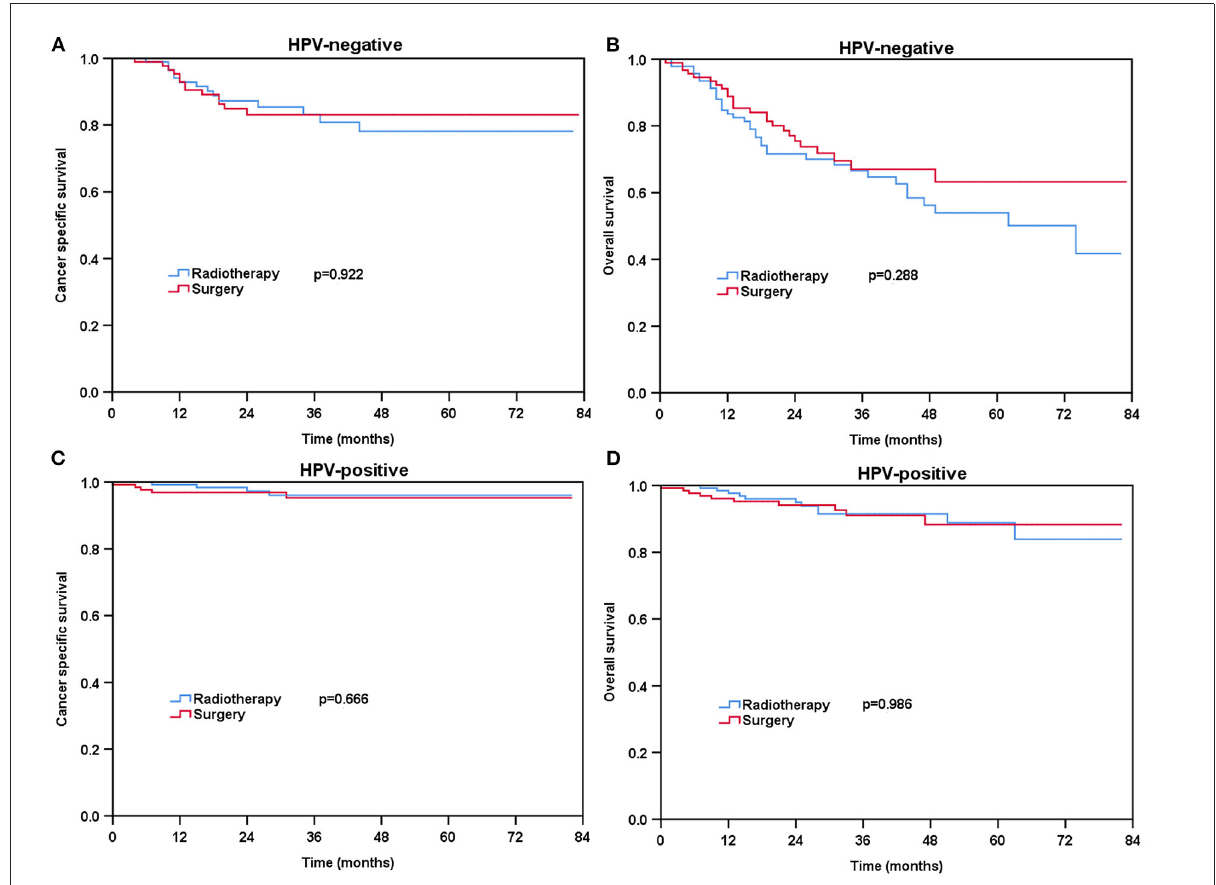
FIGURE4 Kaplan-Meier plots of cancer-specific survival (A) and overall survival (B) for HPV-negative patients and cancer-specific survival (C) and overall survival (D) for HPV-positive patients after